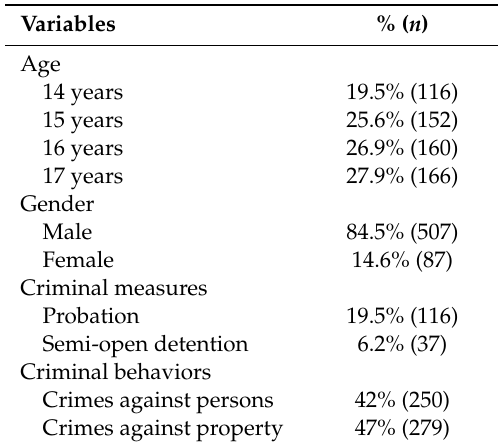
Table 1. Frequency and percentage of the juvenile’s